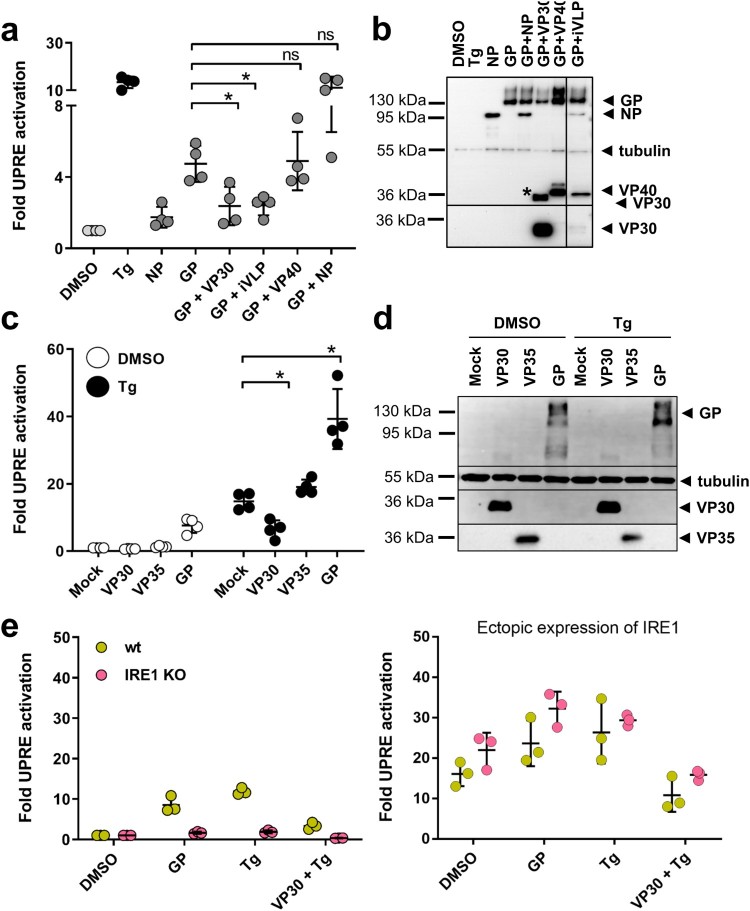
VP30 reduces GP- and Tg-induced UPRE-dependent signalling. (a) HuH7 cells were transfected with plasmids encoding the indicated MARV proteins and the UPRE-specific luciferase reporter plasmids as described in the legend to Figure 1. To express viral proteins, 0.5 µg of each plasmid was used in the transfection. In the iVLP setting, which involved the use of a combination of plasmids encoding all MARV proteins, the plasmid amounts used in transfection were as described by Wenigenrath et al. [25]. The experiment was repeated 4 times. (b) Equal amounts of lysates of transfected HuH7 cells were subjected to Western blot analysis using monoclonal antibodies. NP, GP, VP30, and tubulin were detected simultaneously; VP40 was stained afterwards on the same blot. The asterisk indicates remaining VP30 staining; irrelevant lines have been removed. (c) VP30-dependent reduction of Tg-induced UPR. Tg (5 nM) was used to induce UPRE-dependent reporter gene expression in VP30-, VP35-, and GP-expressing cells that had been transfected as described in the legend to Figure 1. The experiment was repeated 4 times. (d) Western blot analysis of cell lysates obtained from c. VP35 was stained with a polyclonal antibody against VP35; GP, VP30, and tubulin were detected afterwards on the same blot using monoclonal antibodies. Each circle represents a sample from an individual experiment, data are shown as the means ± SD. (e) To analyse UPRE-dependent luciferase activity, HAP1 cells (wt, shown in yellow) or HAP1 IRE1 KO cells (shown in pink) were transfected, treated and harvested as described for HuH7 cells. To restore IRE1 signalling in KO cells, the KO cells were transfected with a plasmid encoding IRE1 (100 ng); The cells were treated either with vehicle (DMSO) or with 5 nM Tg for 16 h. The experiments were performed three times. Each circle represents a sample from an individual experiment, data are shown as the means ± SD.